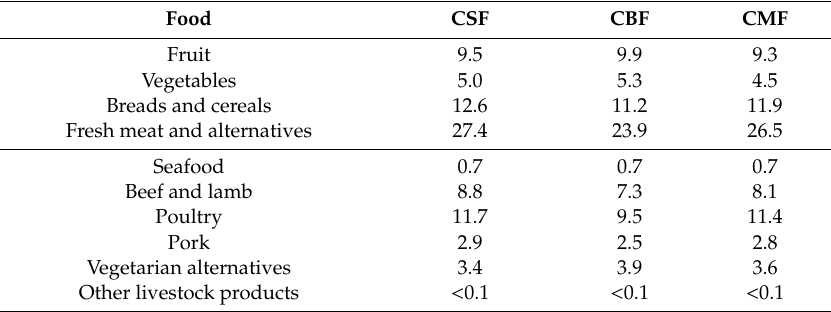
Table1. Contributionofdi ff